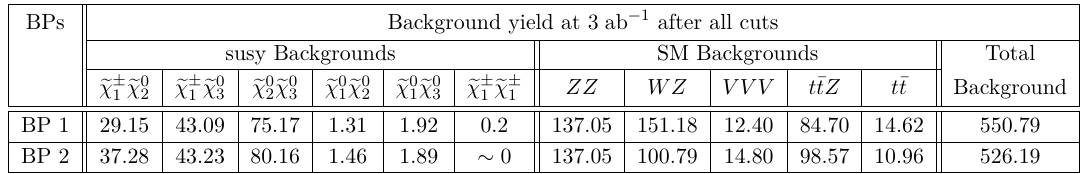
Table 10. The background yield at 14 TeV with 3 ab − 1 of integrated luminosity after the cut-based analysis for the two benchmark points in b-tag